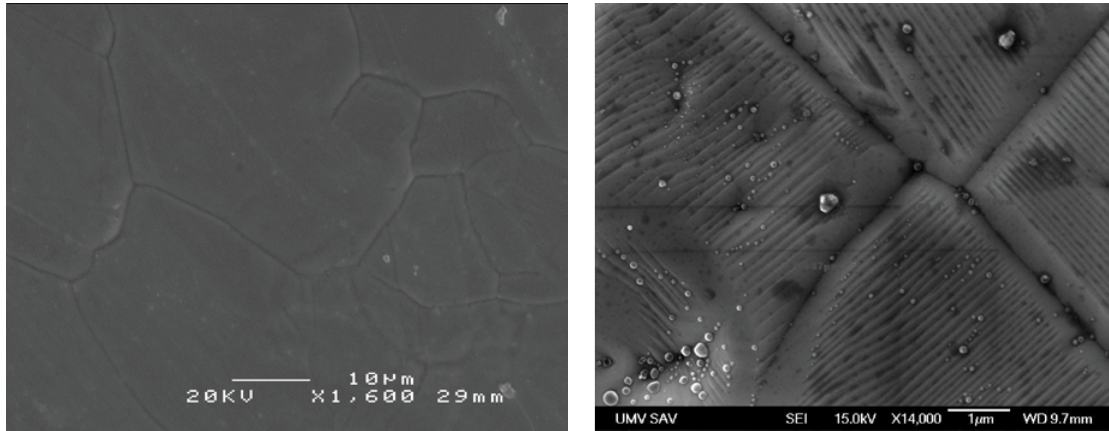
Figure 5. Scanning electron micrograph of the unpolished surface of a textured Ni tape at different magnifications.